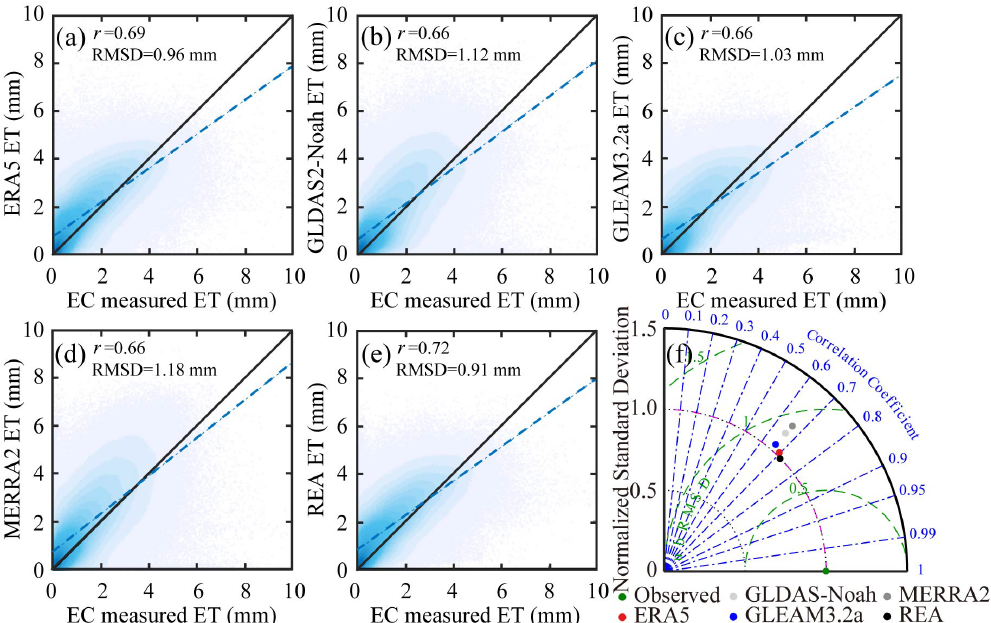
Figure 5. (a–e) Scatterplots and (f) Taylor diagrams of daily ground-measured ET and ET from different products. Linear fits are plotted in blue, and the 1 : 1 line is depicted. The correlation coefficients ( r ) have passed the 5% significance test.